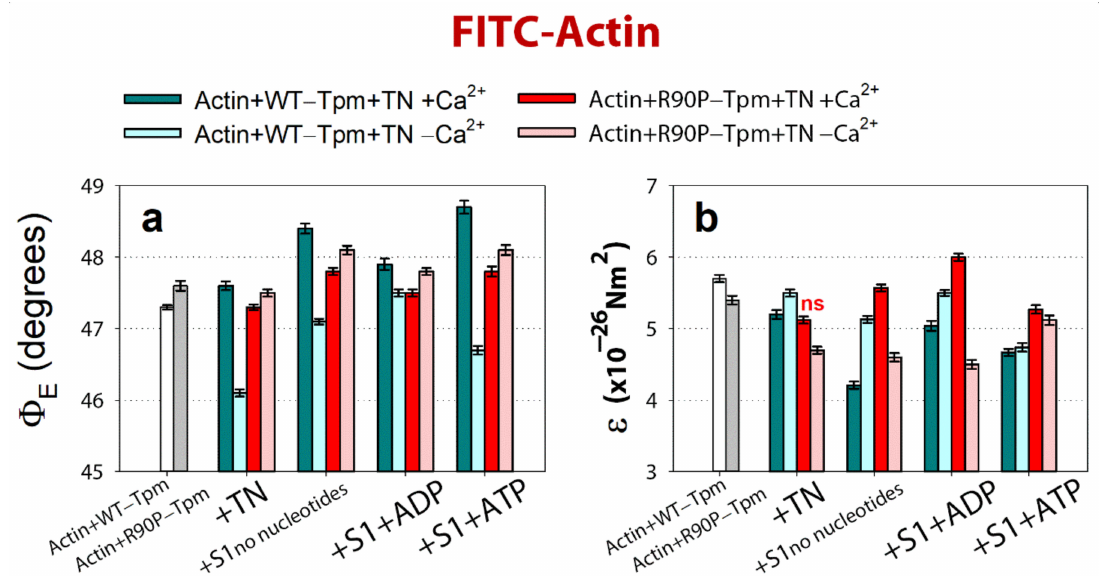
Figure 7. The effect of troponin and Ca 2+ on the values of Φ E ( a ) and ε ( b ) of the polarized fluorescence for FITC-phalloidin- Actin, in the presence of the WT-Tpm or R90P-Tpm under conditions simulating the sequential steps of the myosin ATPase cycle. The first and second entries from the left in each panel present the data obtained in the absence of S1. Calculations of Φ E and ε values, preparation of the fibers, their composition, and the conditions of the experiments are described in Materials and Methods. The data represent the mean values for 8–10 fibers for each experimental condition. Both in the absence and in the presence of nucleotides, the Φ E and ε values for the WT-Tpm and R90P-Tpm are significantly altered by troponin and Ca 2+ ( p < 0.05). Index “ns” marks unreliable difference in the value for ε between the WT and mutant tropomyosins. Error bars indicate ± SEM. The values of N are close to